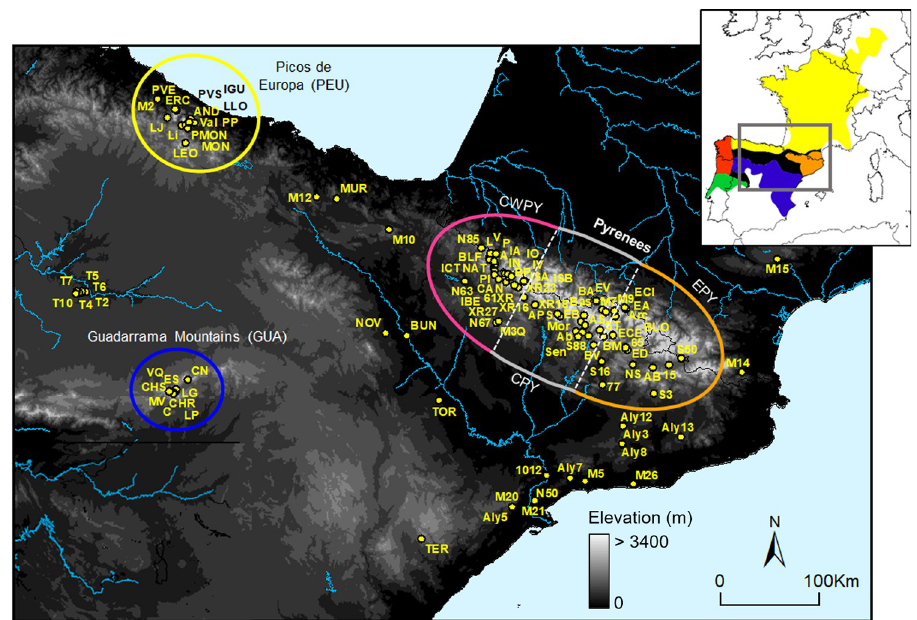
Fig 1. Geographic location of sampling sites for Alytes obstetricans / almogavarii . The analysed mountain regions are circled in colour: eastern Pyrenees (EPY, orange), central Pyrenees (CPY, grey), central-western Pyrenees (CWPY, pink), Picos de Europa mountains (PEU, yellow), and Guadarrama Mountain Range (GUA, blue). In the Pyrenees, dashed lines delimit the three geographic sections (eastern, central and western Pyrenees). For population codes and further information on sampling sites see S1 Table. The inset map shows the distribution of the main lineages: orange —ND4 haplogroups E-F ( A . almogavarii ), yellow—ND4 haplogroup B ( A . o . obstetricans ), blue—ND4 haplogroup A ( A . o . pertinax ), red—ND4 haplogroup C ( A . o . boscai ), green—ND4 haplogroup D ( A . o . boscai ), black—unclear (adapted from Dufresnes and Martı´nez-Solano [23]).